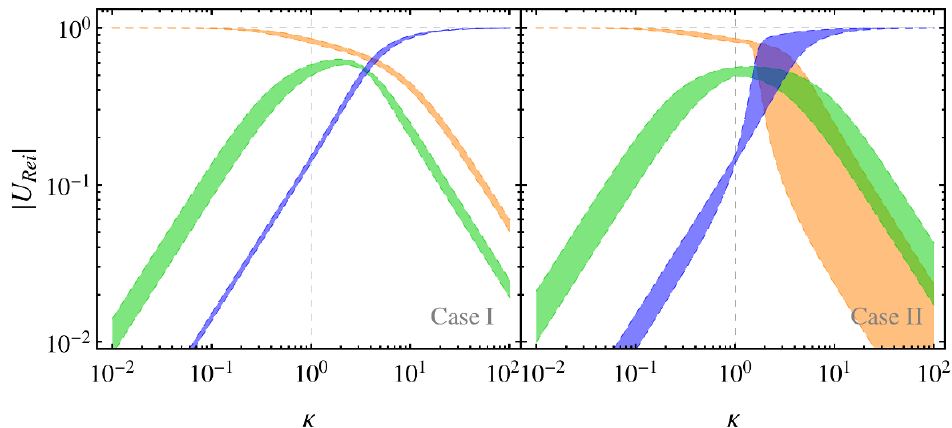
Figure 6 . Modulus of U R 1 i for our NO solutions (cases I and II) for i = 1 ; 2 ; 3 (orange, green, blue) as a function of (cid:20) . We use the 3- (cid:27) ranges in ref. [56] for the observables not (cid:12)xed by